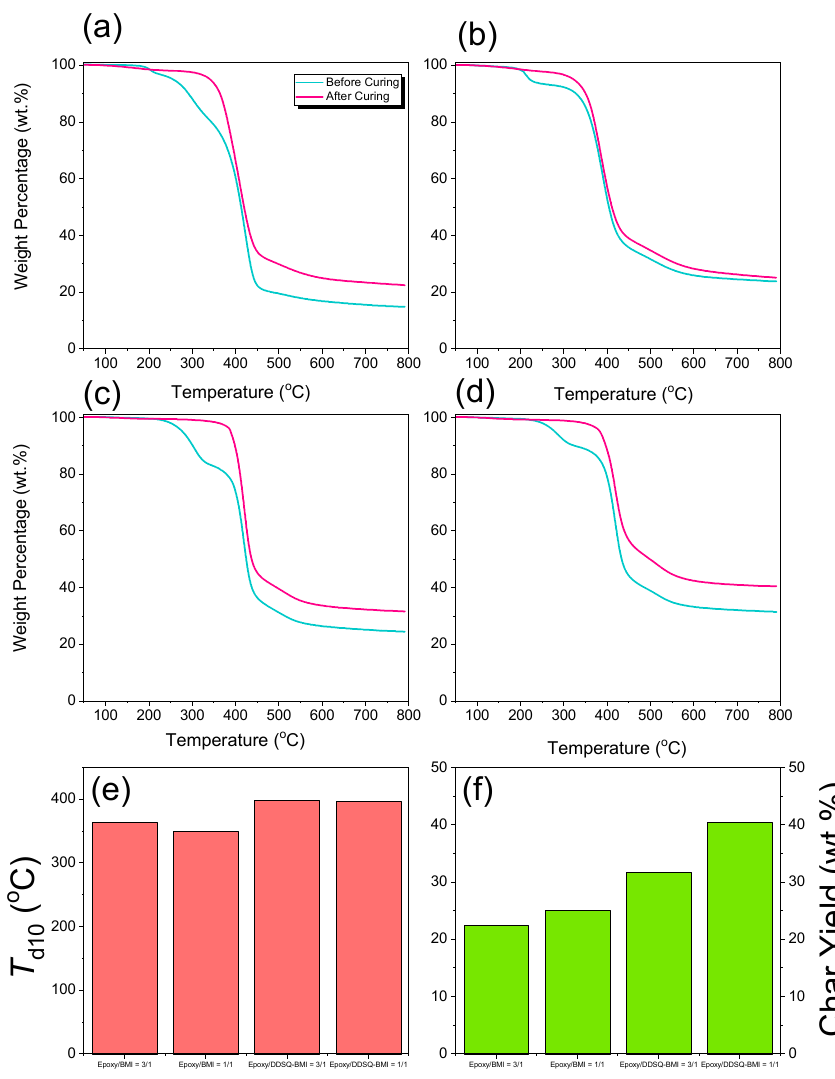
Figure 5. TGA analyses of ( a ) epoxy/BMI = 3/1, ( b ) epoxy/BMI = 1/1, ( c ) epoxy/DDSQ-BMI = 3/1, and ( d ) epoxy/DDSQ-BMI = 1/1 hybrids before and after the thermal polymerization procedure, and the corresponding T d value ( e ) and char yield ( f ).